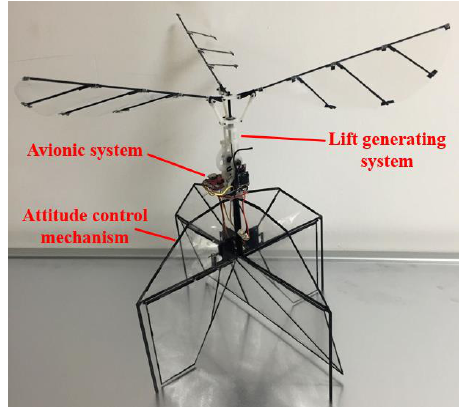
Figure 1. Three-wing FWR-UAV.